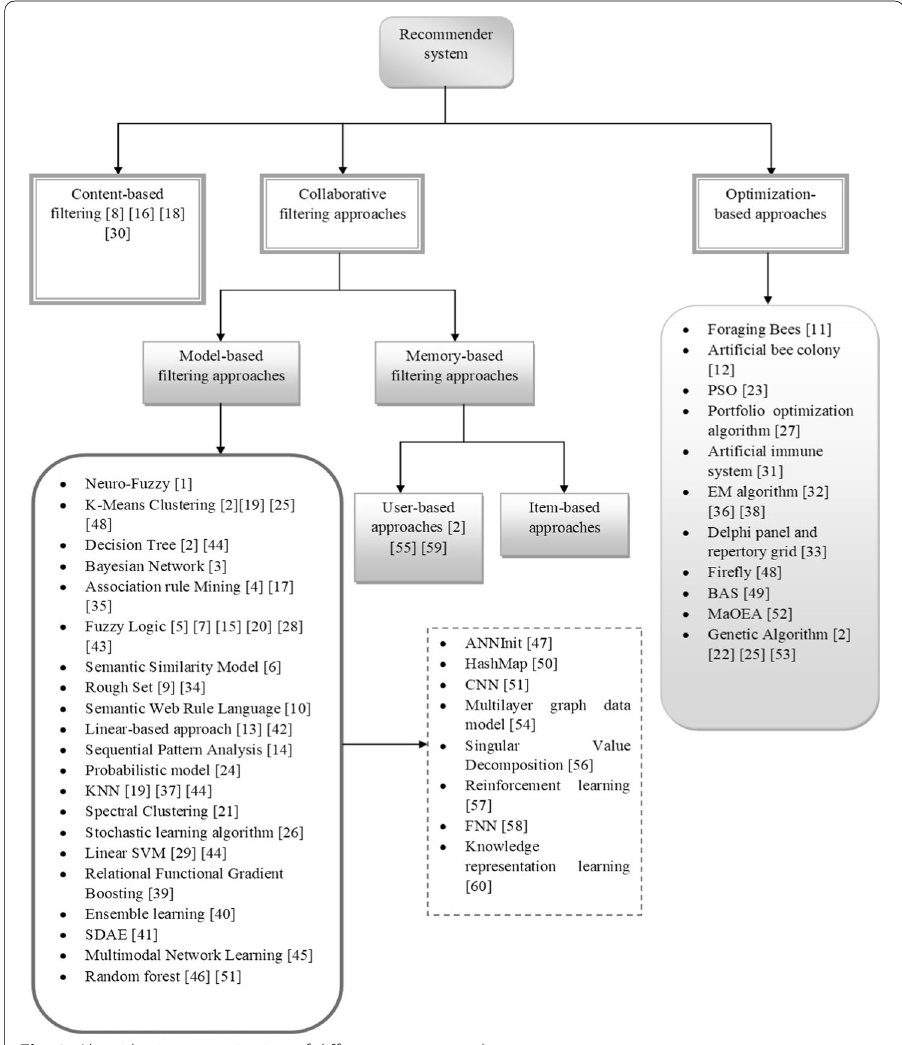
Fig. 8 Algorithmic categorization of different recommender